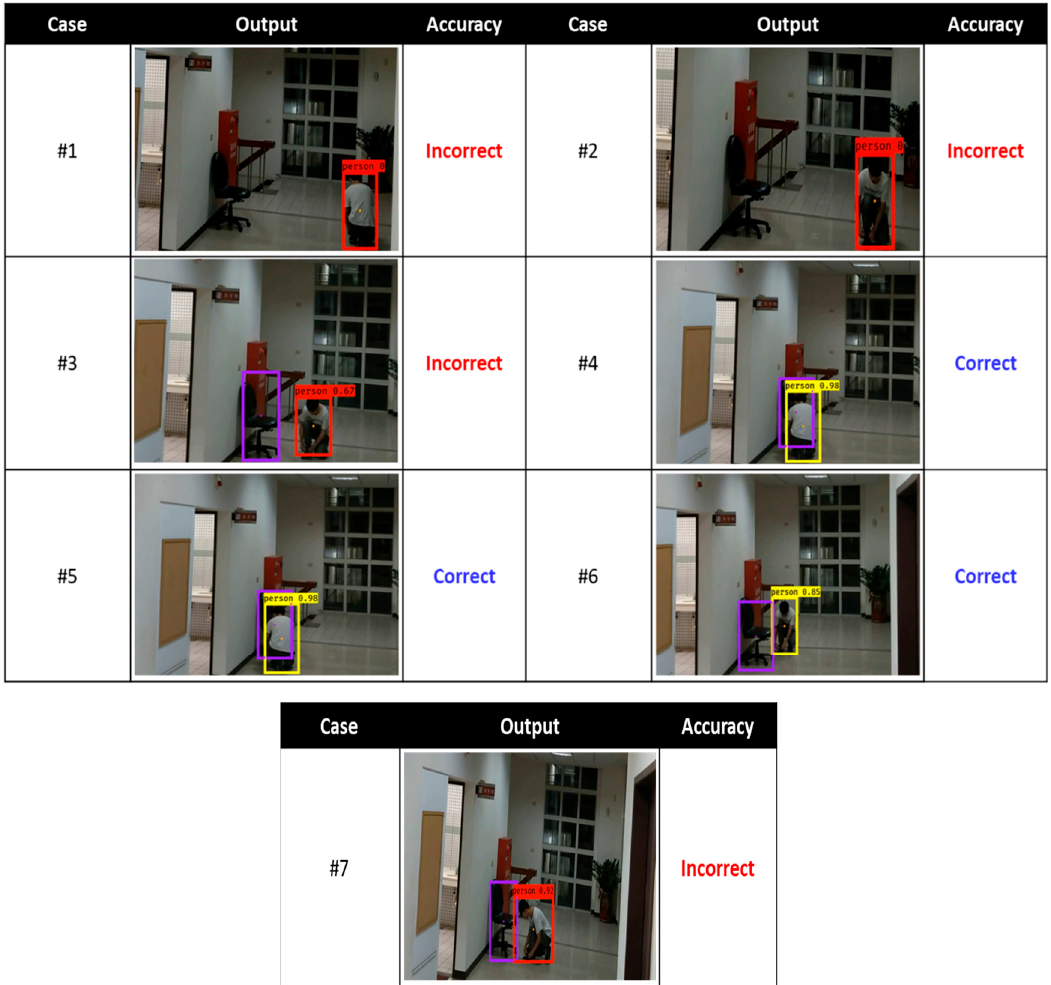
Figure 15. The results of the squatting test cases.